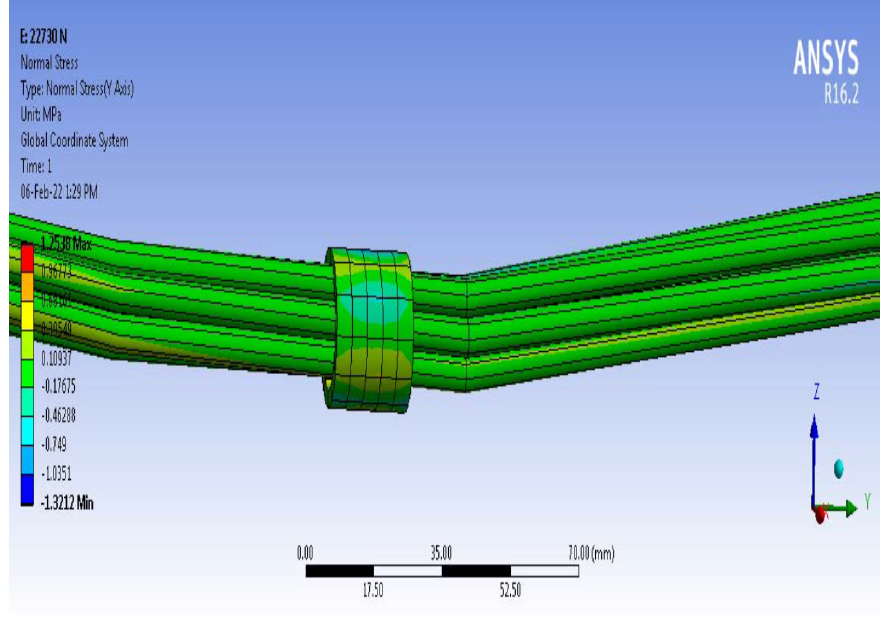
Figure 14. Phase I Normal Stress distributions on steel wire rope.